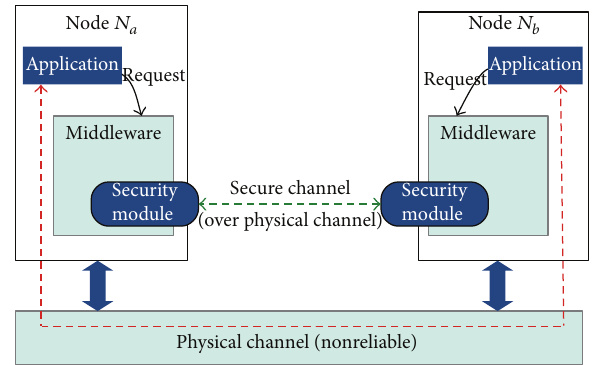
Figure 1: Reliable communication using a secure